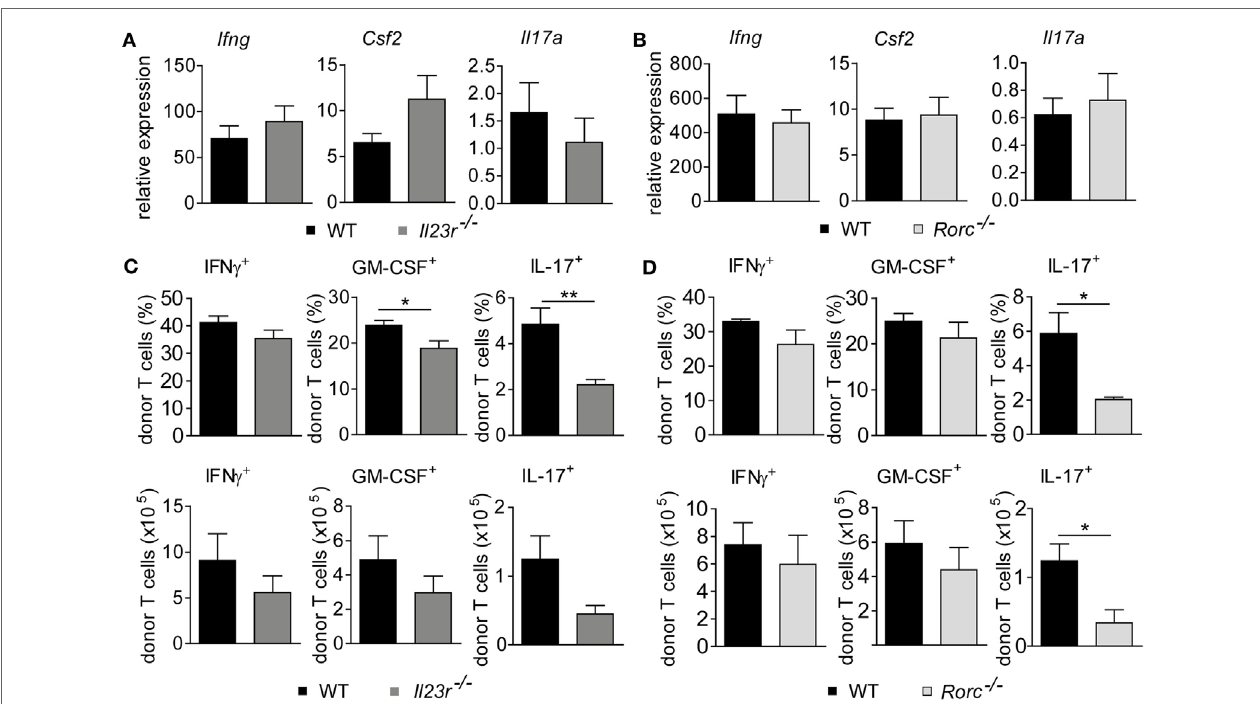
FigUre 4 | Genetic depletion of retinoic acid-related orphan receptor gamma t-dependent T helper cells preserves the granulocyte-macrophage colony-stimulating factor (GM-CSF) expressing donor T cell pool. Experimental graft-versus-host disease (GvHD) induction was performed as described in Figures 1 and 2 . (a) Gene expression levels in total colonic tissue of wild-type (WT) and Il23r − / − donor T cell receiving mice of Ifng , Csf2 (WT n = 14; Il23r − / − n = 15) and Il17a (WT n = 9; Il23r − / − n = 5) transcripts were analyzed by quantitative real-time PCR (qPCR). (B) Gene expression levels in total colonic tissue of WT and Rorc − / − donor T cell receiving mice of Ifng , Csf2 (WT n = 17; Rorc − / − n = 14) and Il17a (WT n = 7; Rorc − / − n = 8) transcripts were analyzed and quantitated by qPCR around day 30, i.e., when allogeneic hematopoietic stem cell transplantation mice displayed fully established signs of intestinal GvHD. Data represent pooled data from two (a) and at least three (B) individual experiments, respectively. (c,D) In addition, lamina propria mononuclear cells of WT ( n = 6) and Il23r − / − ( n = 6) T cell receiving mice (c) or WT ( n = 4) and Rorc − / − ( n = 3) T cell receiving mice (D) were assessed by flow cytometry for the frequencies and absolute numbers of GM-CSF-, IFN γ - or interleukin 17a (IL-17a)-producing CD4 + donor T cells, respectively, employing intracellular cytokine staining techniques. Displayed data are derived from one representative of two independent experiments and were analyzed by Student’s t -test. * p < 0.05 and ** p < 0.01 was considered significant. All data are shown as mean ±